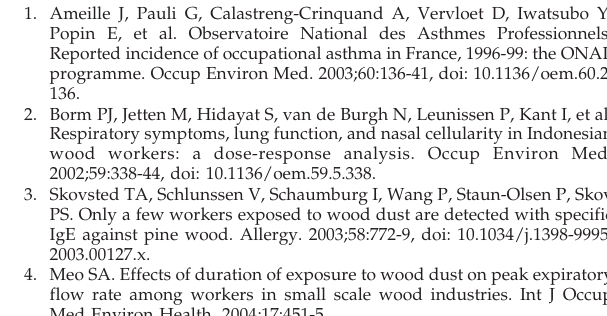
Values are presented as mean ¡ SD of percent predicted (for each group; n=66). FVC: forced vital capacity; FEV 1 : forced expiratory volume in one second; MMEF: maximal mid-expiratory flow; PEF: peak expiratory flow; MEF 75 , MEF 50 , and MEF 25 : maximal expiratory flow at 75%, 50%, and 25% of the FVC, respectively; Stat. dif.: statistical